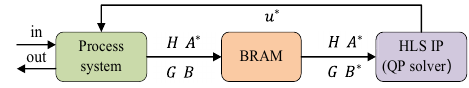
Figure 4 The main project of Vivado IDE